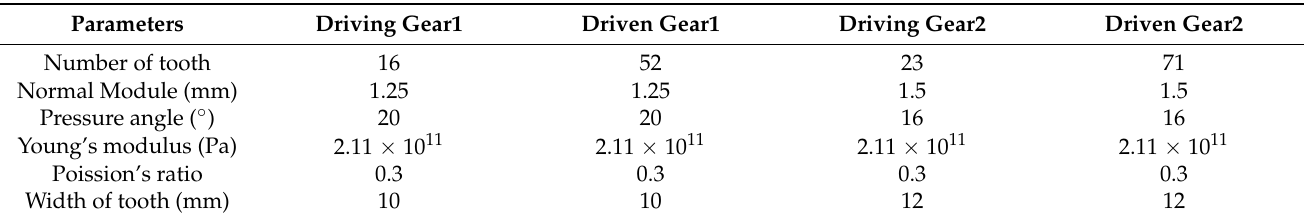
Table 1. Parameters of